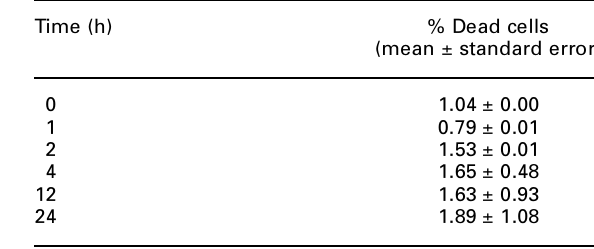
a T-84 cells were treated with interleukin-1 (30ng/ml) for different time periods. Cell viability was measured using the trypan blue exclusion